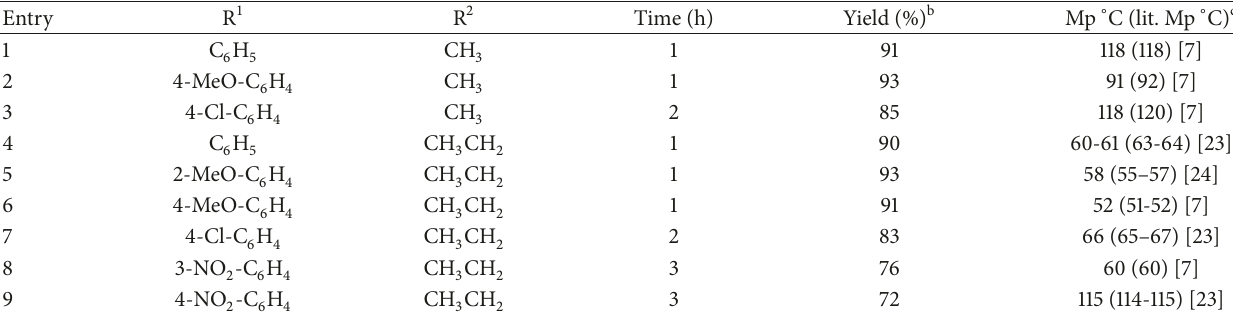
Table 2: Hantzsch reaction of different substrates catalyzed by [DDPA][HSO 4 ] a